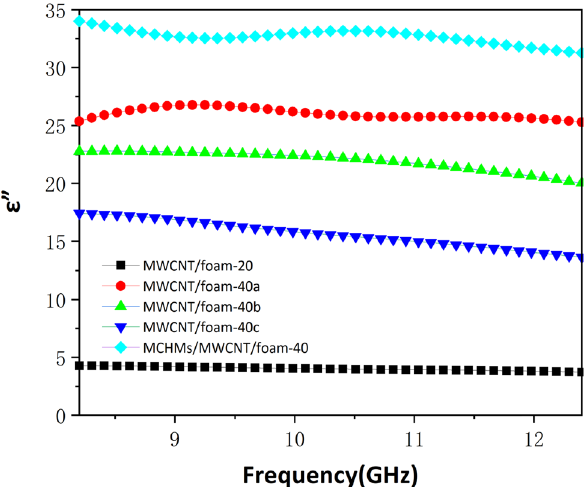
Figure 2: The value of ε ″ of MWCNT/foam - 20, MWCNT/foam - 40a, MWCNT/foam - 40b, MWCNT/foam - 40c, and MCHMs/MWCNT/foam - 40.